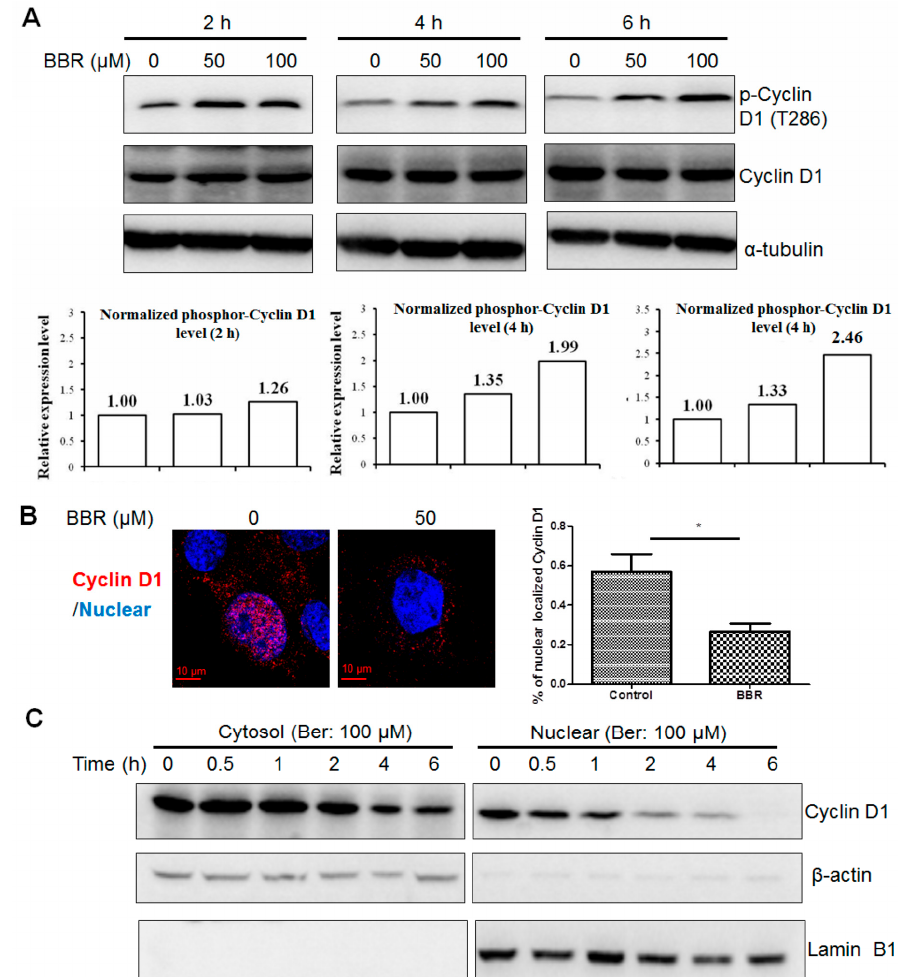
Figure 4. Berberine induces Cyclin D1 phosphorylation at T286 site and its nuclear export in HepG2 cells. ( A ) Cells were treated with berberine in the presence of MG132. The expression of phosphor-Cyclin D1 was normalized by total Cyclin D1 to avoid fluctuation induced by dynamic degradation of Cyclin D1; ( B ) Cells were treated with berberine for 6 h and fixed. Cyclin D1 was stained (Red) and DAPI was used to stain the nucleus; ( C ) Cells were treated with berberine and cytosolic and nuclear fractions were collected. β -actin and Lamin B1 were used as internal controls, respectively. * p < 0.05.